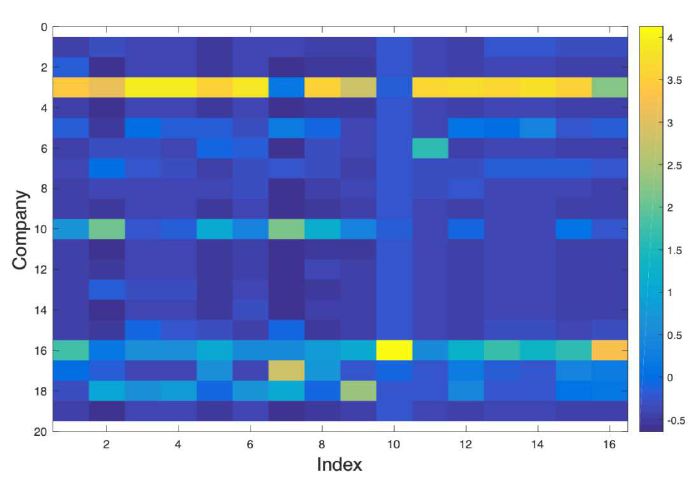
Figure 1. Heat-map of the Z’ matrix (first step)